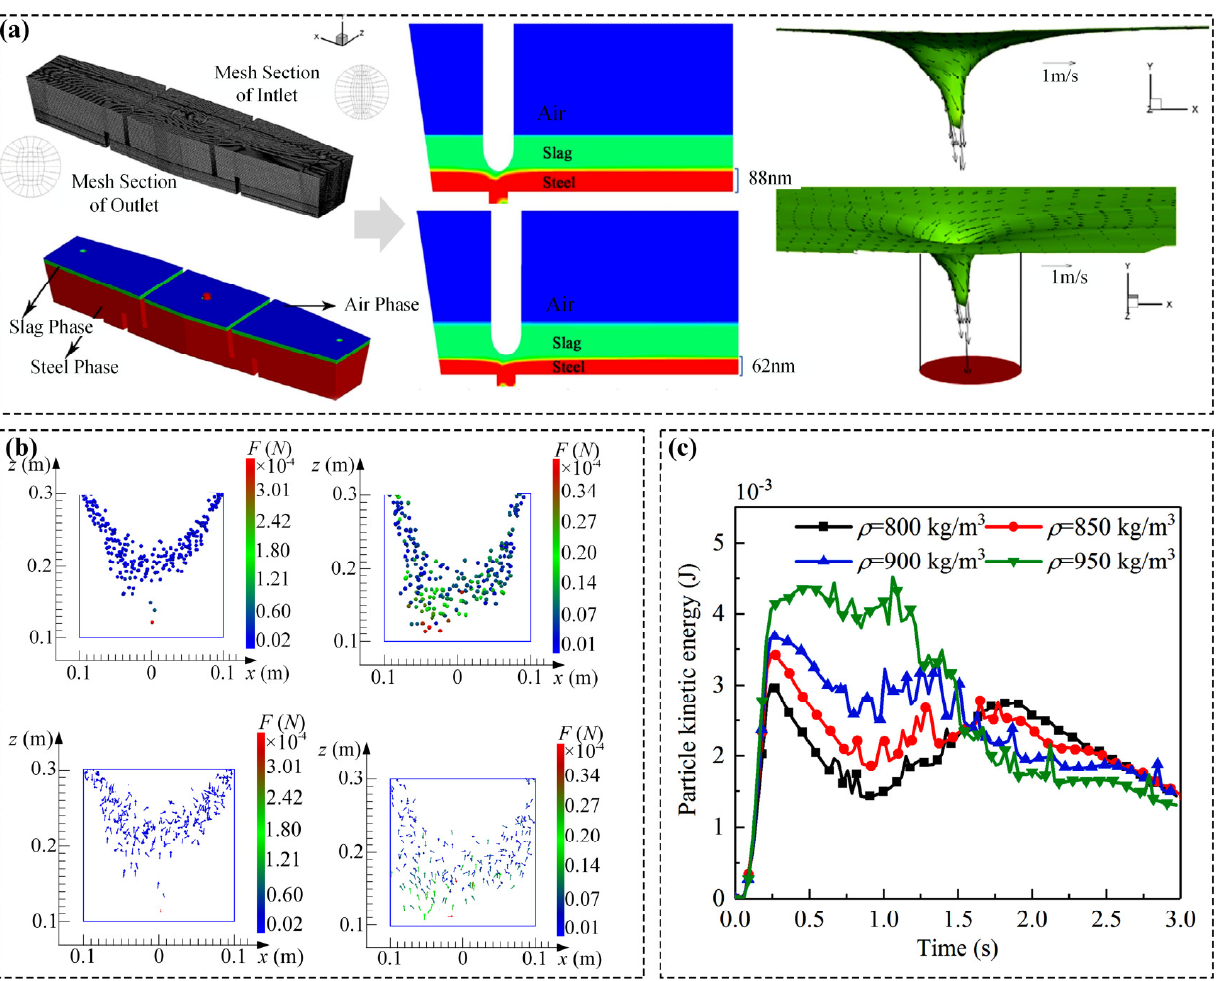
Figure 11. Flow pattern tracking of multiphase vortex. ( a ) Typical flow patterns. Reproduced with the permission of John Wiley and Sons. (Reprinted with permission from Ref. [90]. 2020, John Wiley and Sons.) ( b ) Force acting on particles in the Ekman pumping process. ( c ) Kinetic energy acting on particles. (Reprinted with permission from Ref. [90,94]. 2020, Elsevier.)